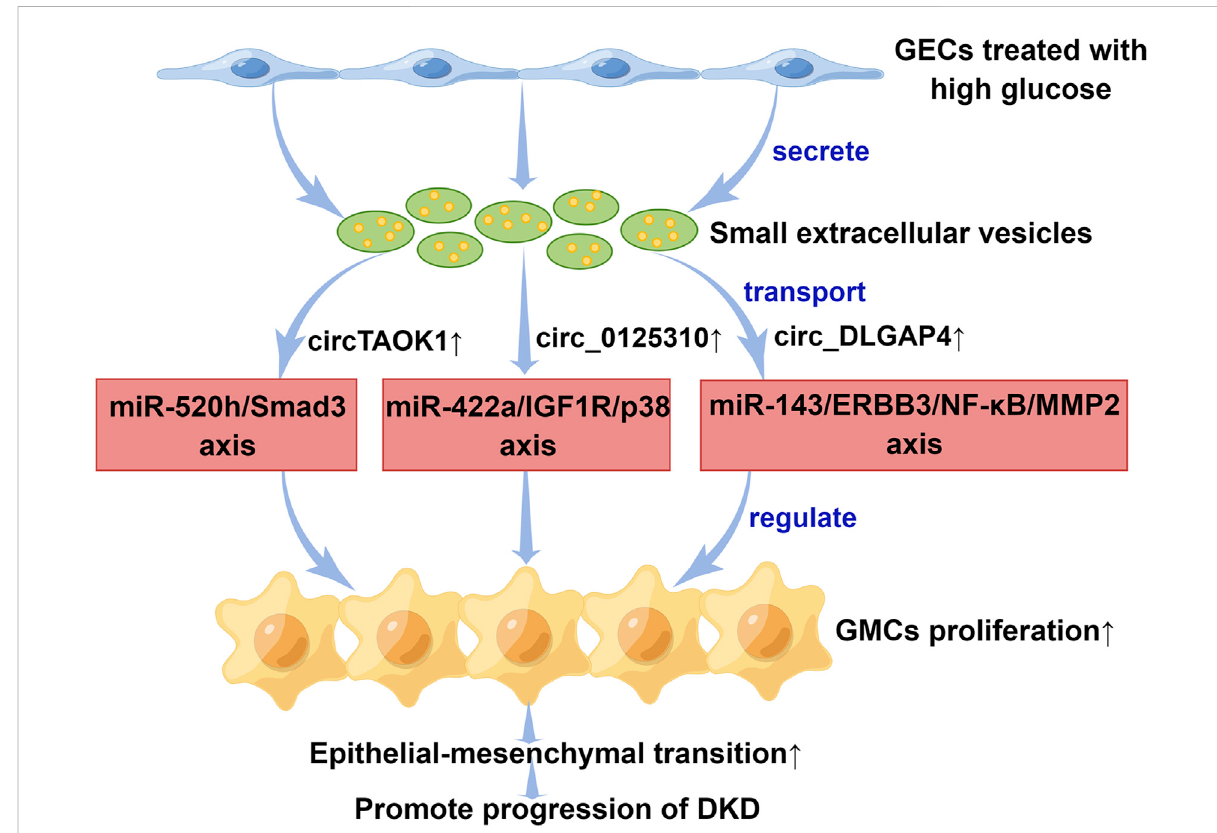
FIGURE 2 The mechanisms of small extracellular vesicle circular RNAs in the progression of diabetic kidney disease. Small extracellular vesicles secreted by GECs promoted epithelial interstitial transition process in diabetic kidney disease through transporting different circular RNAs. DKD, diabetic kidney disease; ERBB3, Erb-b2 receptor tyrosine kinase 3; GECs, glomerular endothelial cells; GMCs, glomerular mesangial cells; IGF1R, insulin-like growth factor 1 receptor; miR, microRNA; MMP2, matrix metalloproteinase 2; NF- κ B, nuclear factor- κ B; Smad3, SMAD family member 3. This fi gure was created by Figdraw (www. fi gdraw.com) (ID: